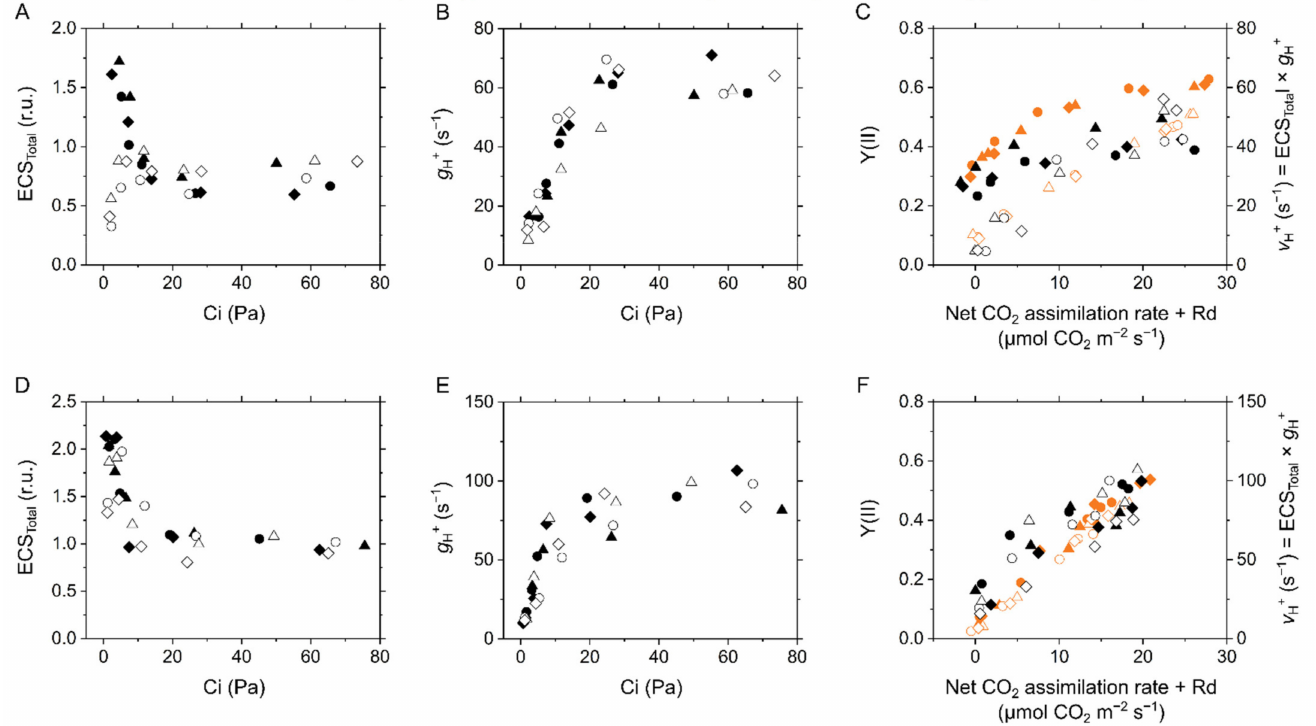
Figure 4. Electrochromic shift (ECS) parameters in the C 3 plant mustard ( A – C ) and the C 4 plant maize ( D – F ). ( A , D ) Total ECS values reflecting proton motive force at various intercellular CO 2 partial pressures (Ci). ( B , E ) Proton conductance of the chloroplast ATP synthase ( g H+ ) at various Ci. ( C , F ) Relationship of proton efflux rate via the ATP synthase ( v H+ ) with CO 2 assimilation rate. Effective quantum yield of PSII, Y(II), are also shown in orange symbols. Dark respiration rate is presented as Rd. Experiments were conducted independently three times, as shown in different symbols (biological replicates) at 21 kPa (closed symbols) and 1 kPa O 2 (open